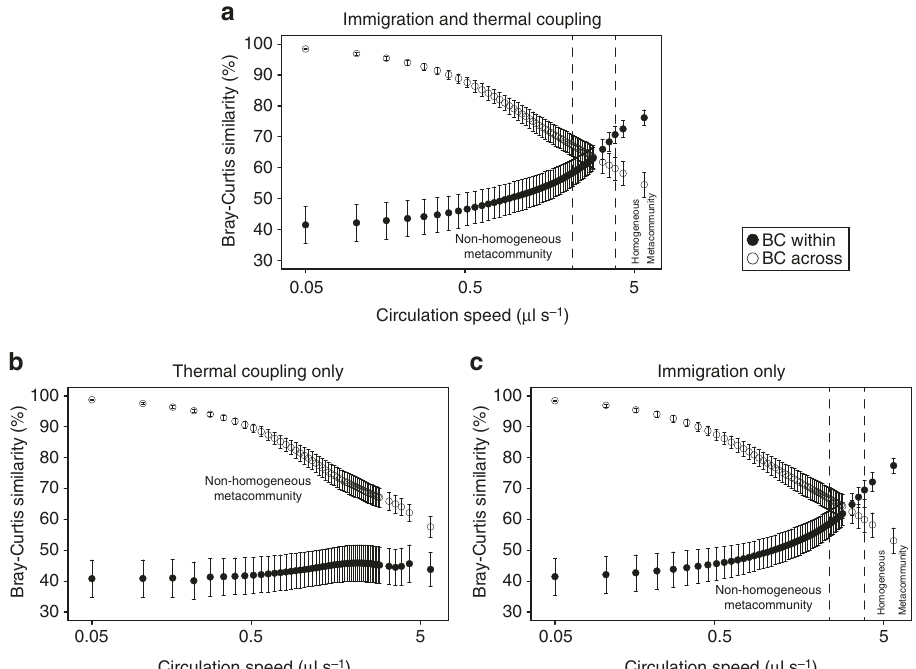
Fig. 6 Community dynamics under the original model and in two alternative scenarios. a Dynamics in the original model that includes both immigration and thermal coupling. b Dynamics in the model that includes only thermal coupling. c Dynamics in the model that includes only immigration. Bray – Curtis (BC) similarity ( y axis) is plotted as a function of increasing circulation speed ( x axis, in logarithmic scale). Vertical dashed lines delimit the range of dispersal under which “ BC within ” is signi fi cantly lower than “ BC across ” (on the left of the left line) and vice versa (on the right of the right line; generalized linear mixed-effects models, corrected two-sided p < 0.05). Vertical bars represent one standard error ( n = 21). Source data are provided as a Source Data fi